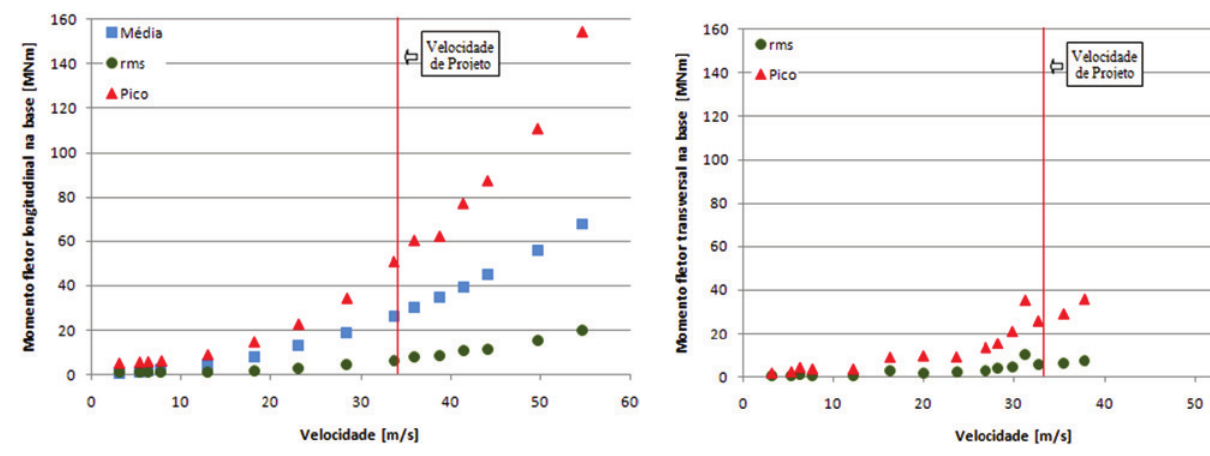
Figure 13 Transverse bending moment at the base of the chimney as a function of the wind speed at the top of the structure. Isolated